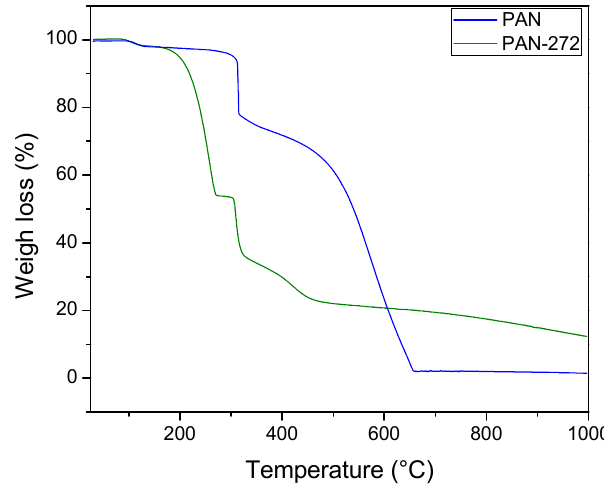
Figure 4. Thermogravimetric analysis of PAN and PAN-272 nanofibers.